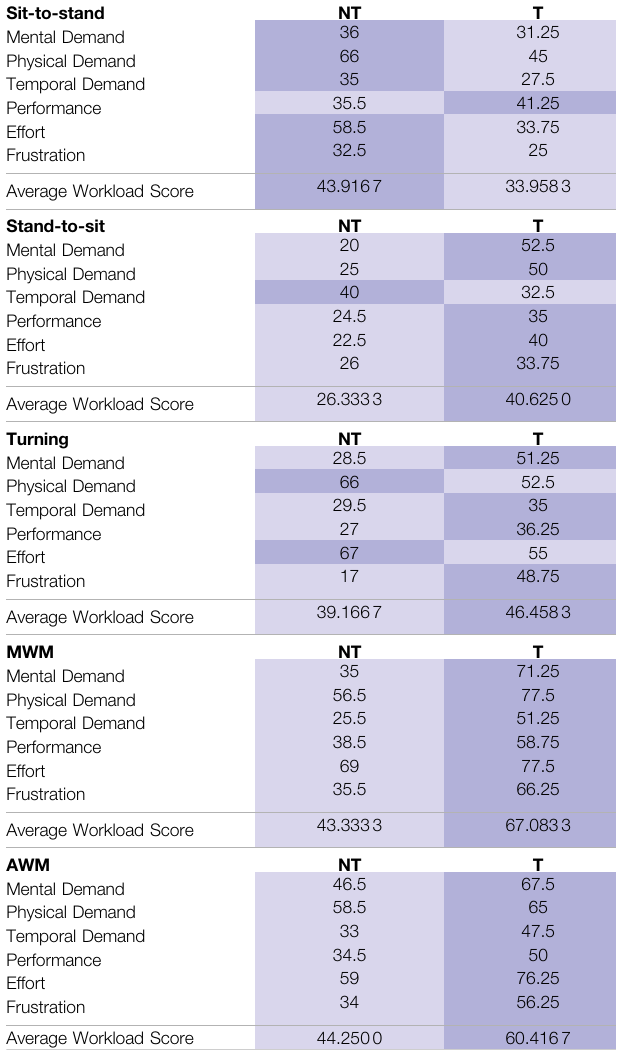
TABLE 1 | Mean RTLX scores for the fi ve tasks of users receiving tutorial and those who did not. Sit-to-stand